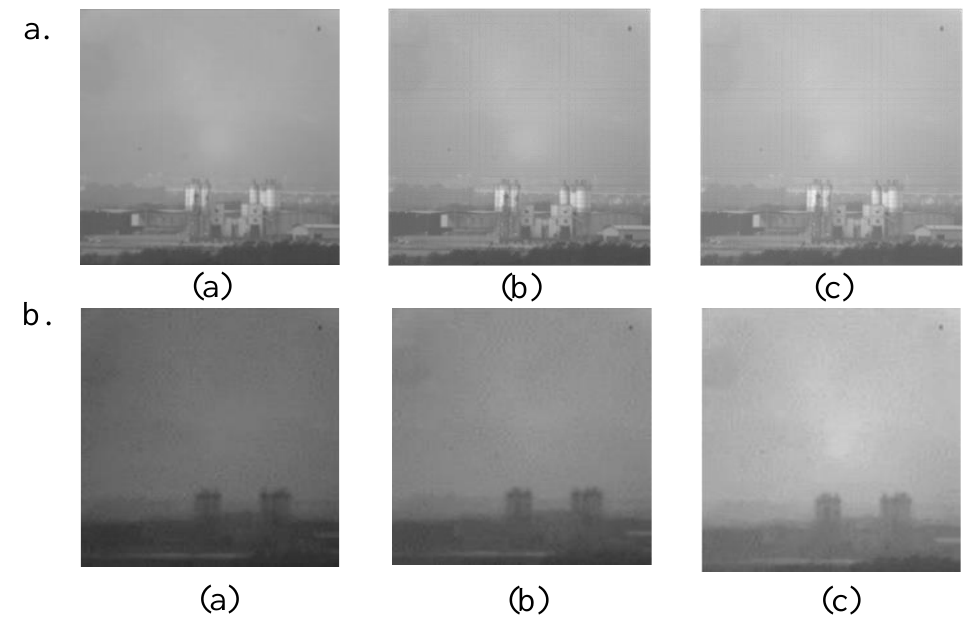
Figure 5. Polarization imaging at three wavelengths in varied weather a . Sunny weather, b . Sea fog environment ( a ) 670 nm ( b ) 530 nm ( c ) 450 nm.